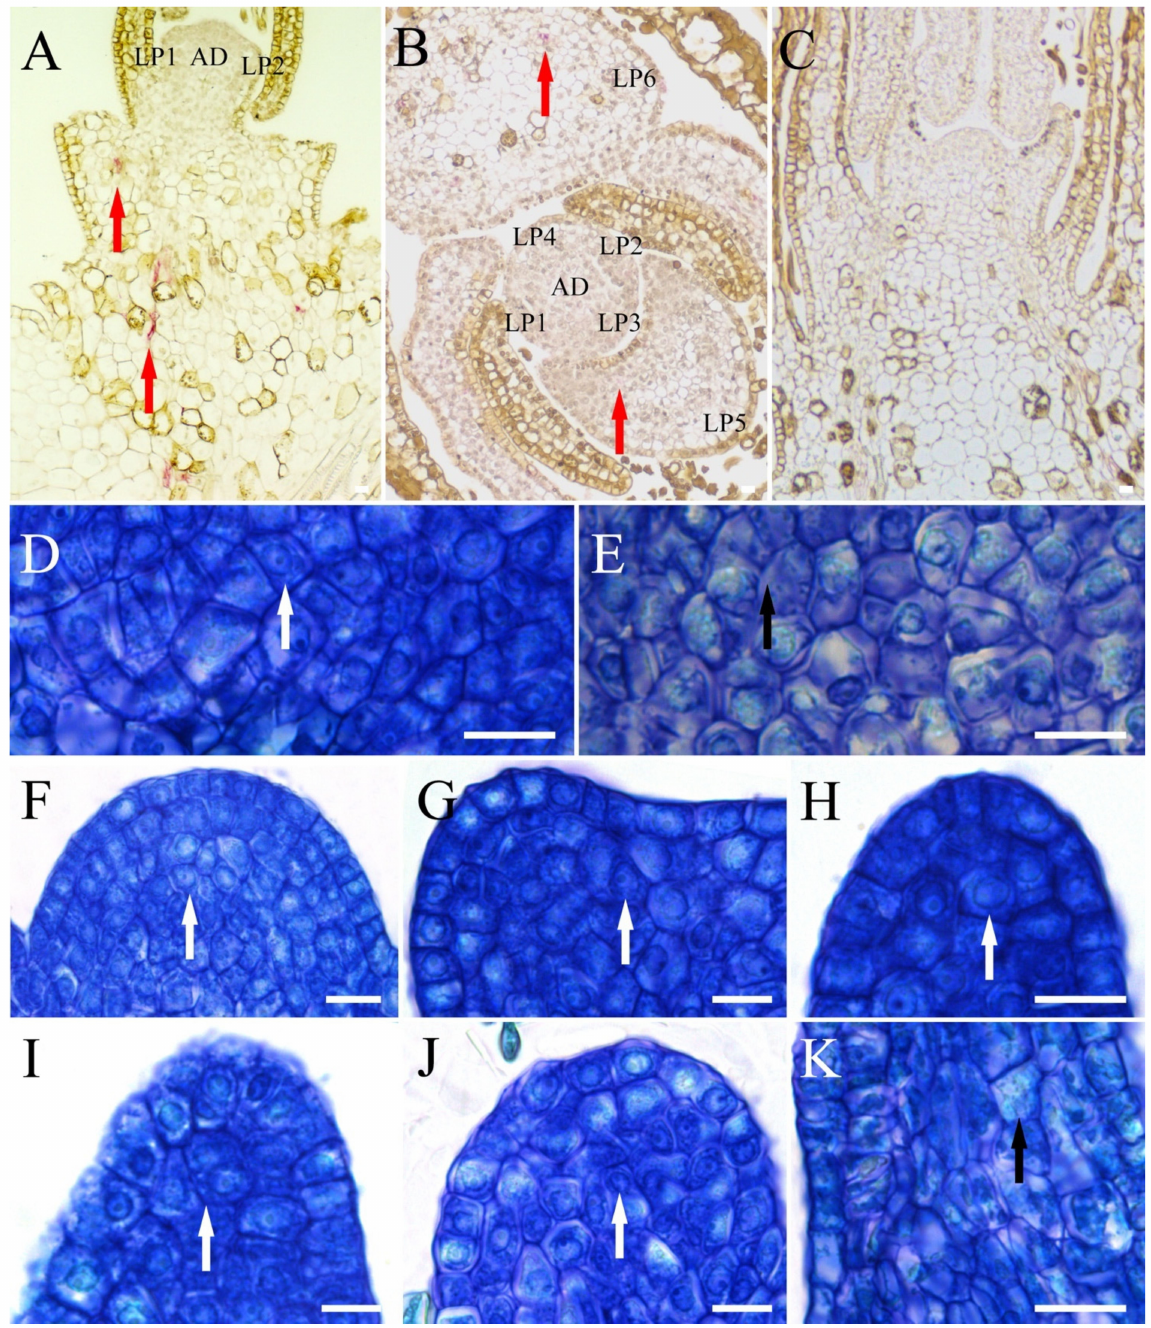
Figure 3. Immunohistological localization of Grapevine leafroll-associated virus-3 (GLRaV-3) in longitudinal section and cross section of shoot tips and histological observations of cell survival patterns in longitudinal sections of shoot tips following cryotherapy in grapevine cultivar Cabernet Sauvignon. Virus-infected cells are indicated by purple color (red arrows) reactions in ( A , B ), whereas no purple color reactions were spot in virus-free cells in ( C ). Surviving cells are densely stained with intact nucleus and nucleolus enclosed in a well-preserved cytoplasm (white arrows) in ( D ) as a positive control, dead cells are cytoplasm condensed with fractured plasma membrane (black arrows) in ( E ) as a negative control. Surviving cells in AD ( F ), and LP 1 ( G ), LP 2 ( H ), LP 3 ( I ), LP 4 ( J ) and dead cells in LP 5 ( K ) following cryotherapy are indicated by white arrows and black arrows. Bars = 10 µ m. Source: Bi et al.